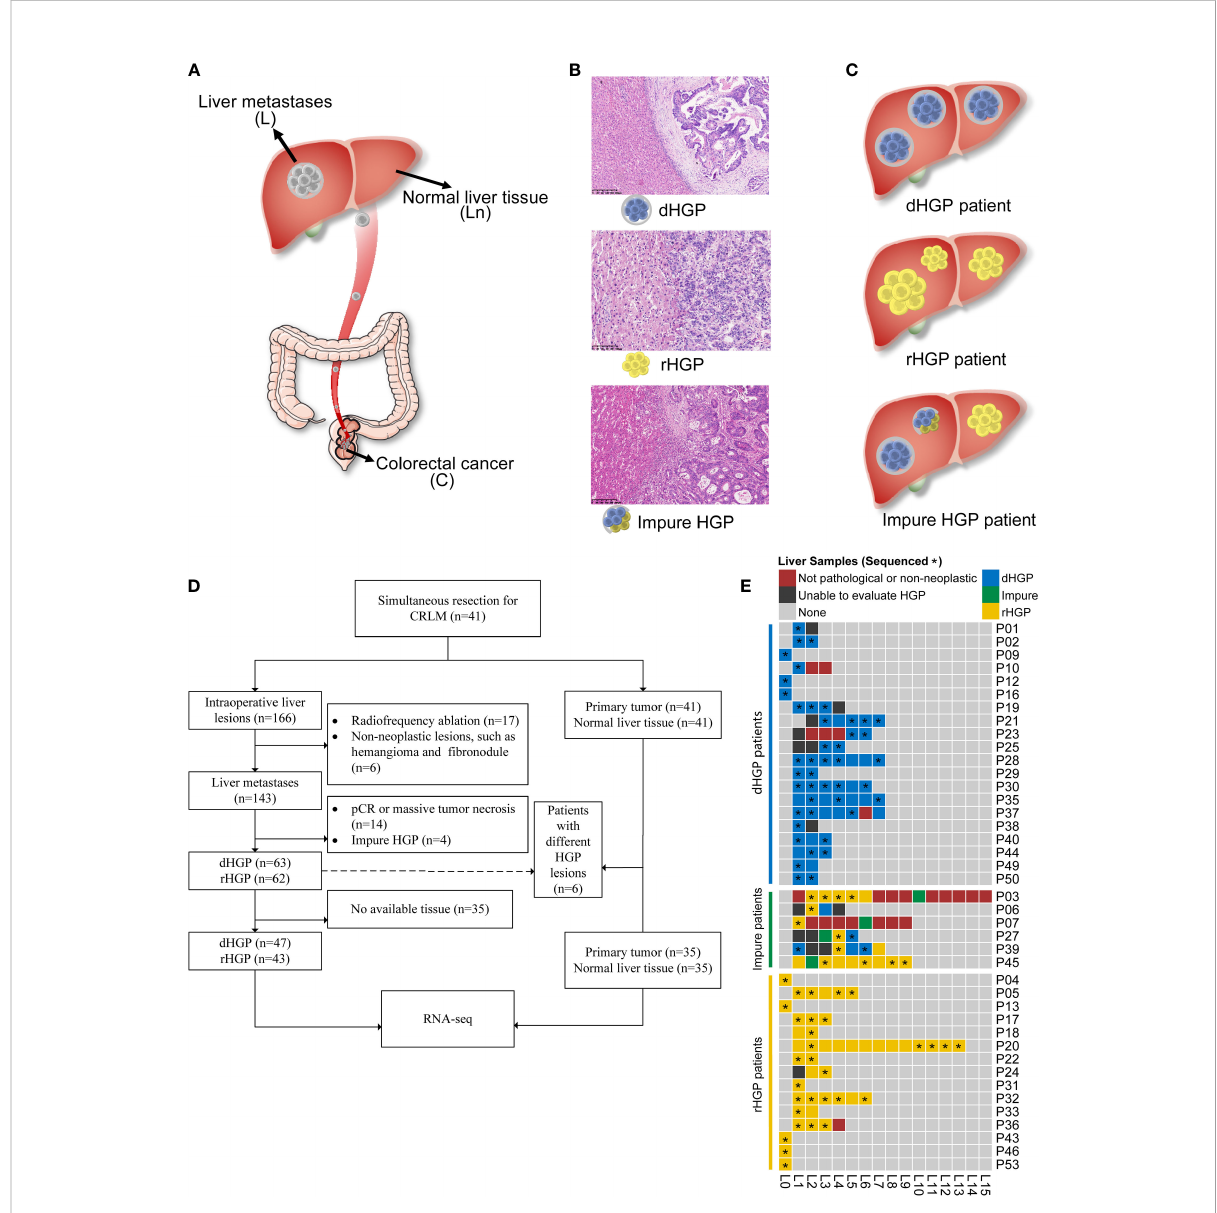
FIGURE 1 Study design. (A) Tissues were obtained from patients undergoing colectomy and hepatic resection in this study. (B) Evaluations of HGP were done for liver metastasis and each patient. (C) Patient enrolment and samples were included in the analyses. Of the 41 enrolled patients, a total of 90 liver metastasis lesions, 35 normal liver tissues, and 35 primary lesions were included in the transcriptome sequencing and analyses. (D) A heatmap depicting the HGP for each liver metastasis and each patient. (E) Pathological evaluation and RNA sequencing of all liver lesions. *: the sample was sent to RNA